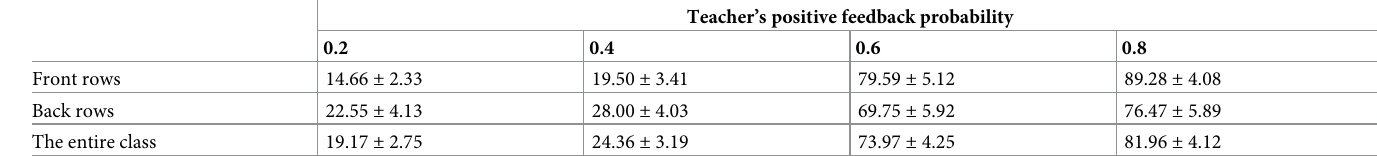
Table 3. Descriptive statistics of classroom engagement for teacher-student proximity and teacher feedback